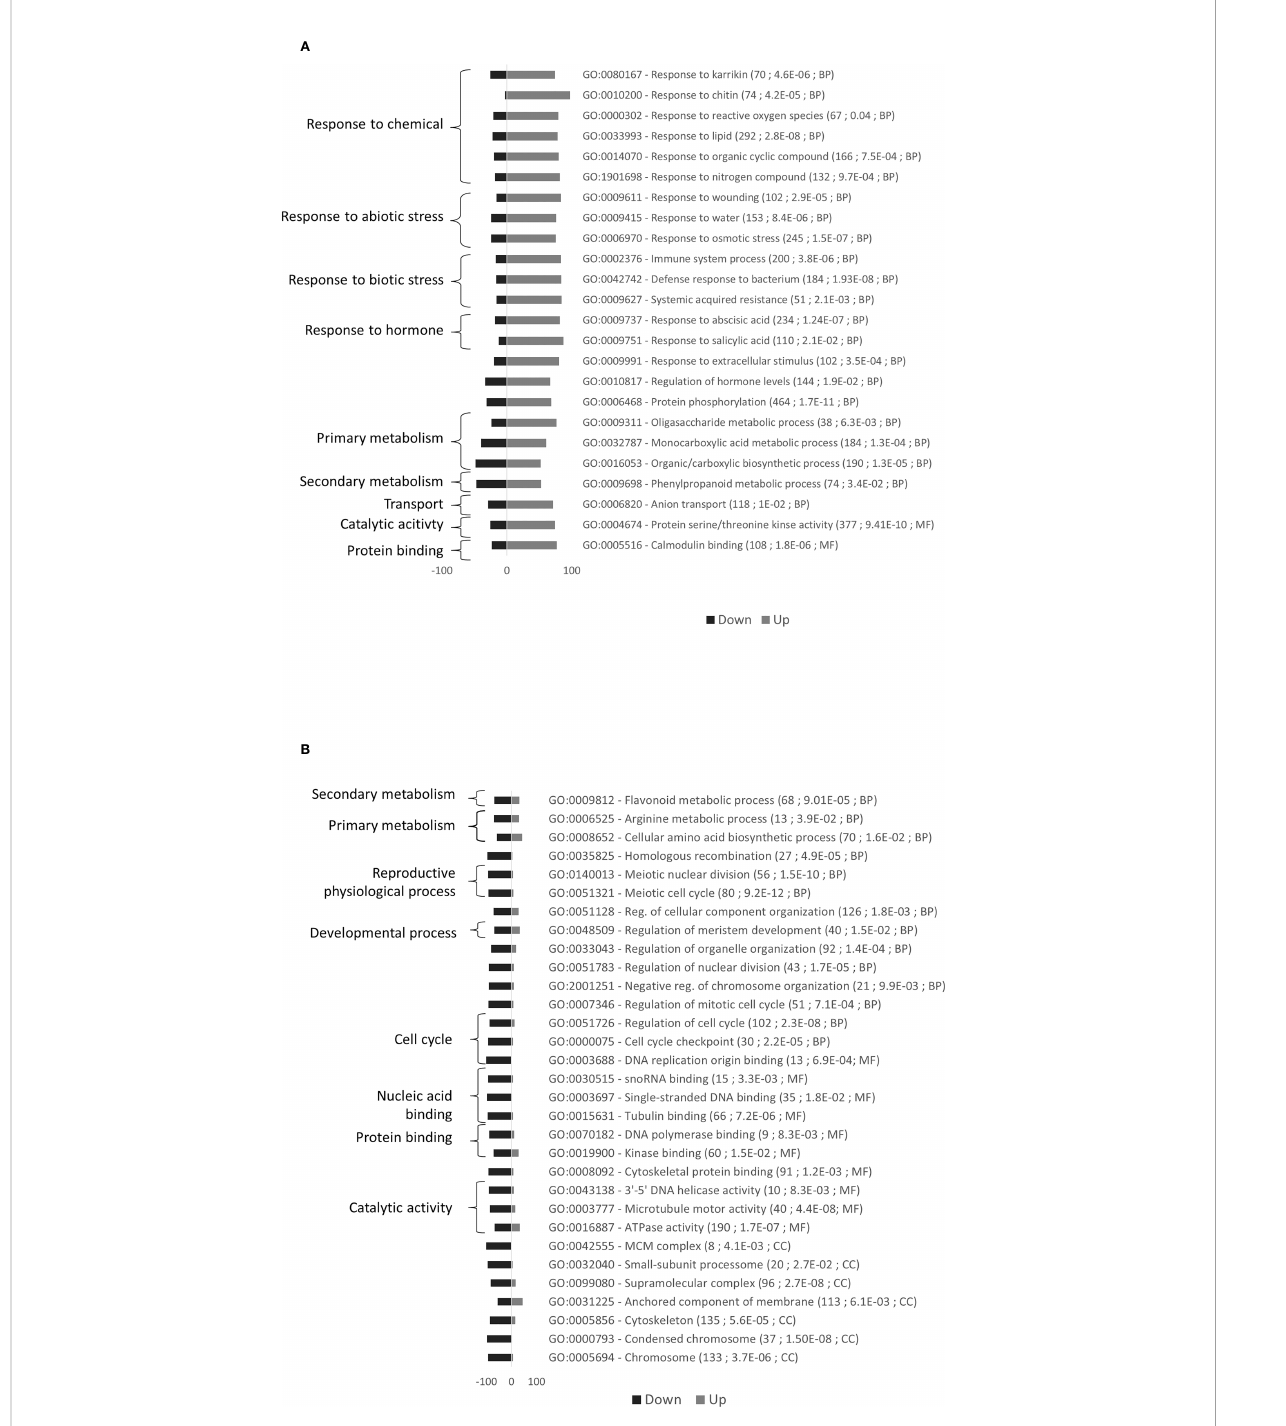
FIGURE 5 Gene Ontology (GO) enrichment analysis for the comparison of gene expression variations induced by GPA infestation of Rubira. (A) Upregulated genes. (B) Downregulated genes. Bars indicate the percentage of genes up- or down-regulated associated to GO terms. A total of 3376 markers were mapped in this enrichment analysis. GO terms with at least a 1.5-fold over-representation and an enrichment adjusted p.value lower than 0.05 are presented. For each GO term, details are given in parentheses: (i) number of P. persica GO annotated genes, (ii) adjusted p.value of enrichment, (iii) GO groups (BP, Biological process; CC, Cellular compartment; MF, Molecular